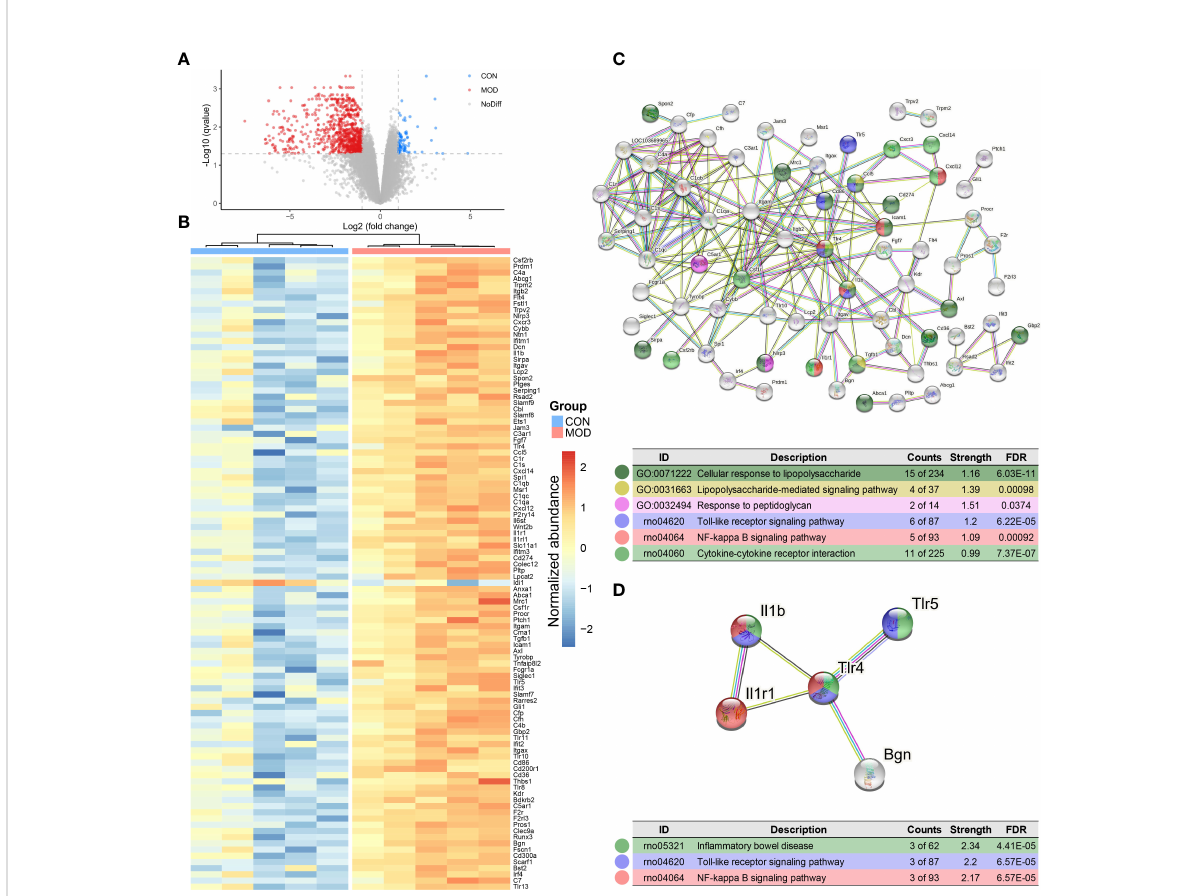
FIGURE 4 Transcriptome analysis of duodenum. (A) Differential expressed genes with DESeq2 analysis. Dotted line: BH FDR < 0.05 and |log2(FC)| > 1 represent signi fi cant (the control group: high expression in blue; the model group: high expression in red). (B) Selected differential genes based on InnateDB database. (C) PPI network based on innate immune response-related protein-coding genes (interaction score > 0.7 and hiding disconnected nodes). (D) The subnetwork clustering with MCL algorithm. Color-coded dots were clustered with GO and KEGG pathway enrichment analysis ( n = 5